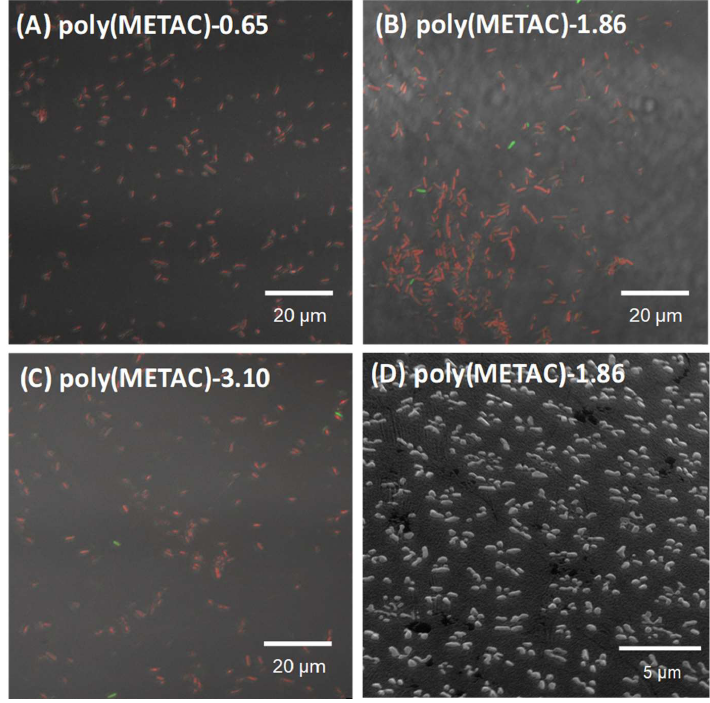
Figure 4. Confocal images of LIVE/DEAD test of E. coli on poly(METAC)-gels at various crosslinker amount; ( A ) 0.65 mol %, ( B ) 1.86 mol %, and ( C ) 3.10 mol %. The E. coli were stained with SYTO9 and PI. ( D ) Scanning electron microscope (SEM) images of the adsorbing E. coli on poly(METAC)-gels- 1.86.